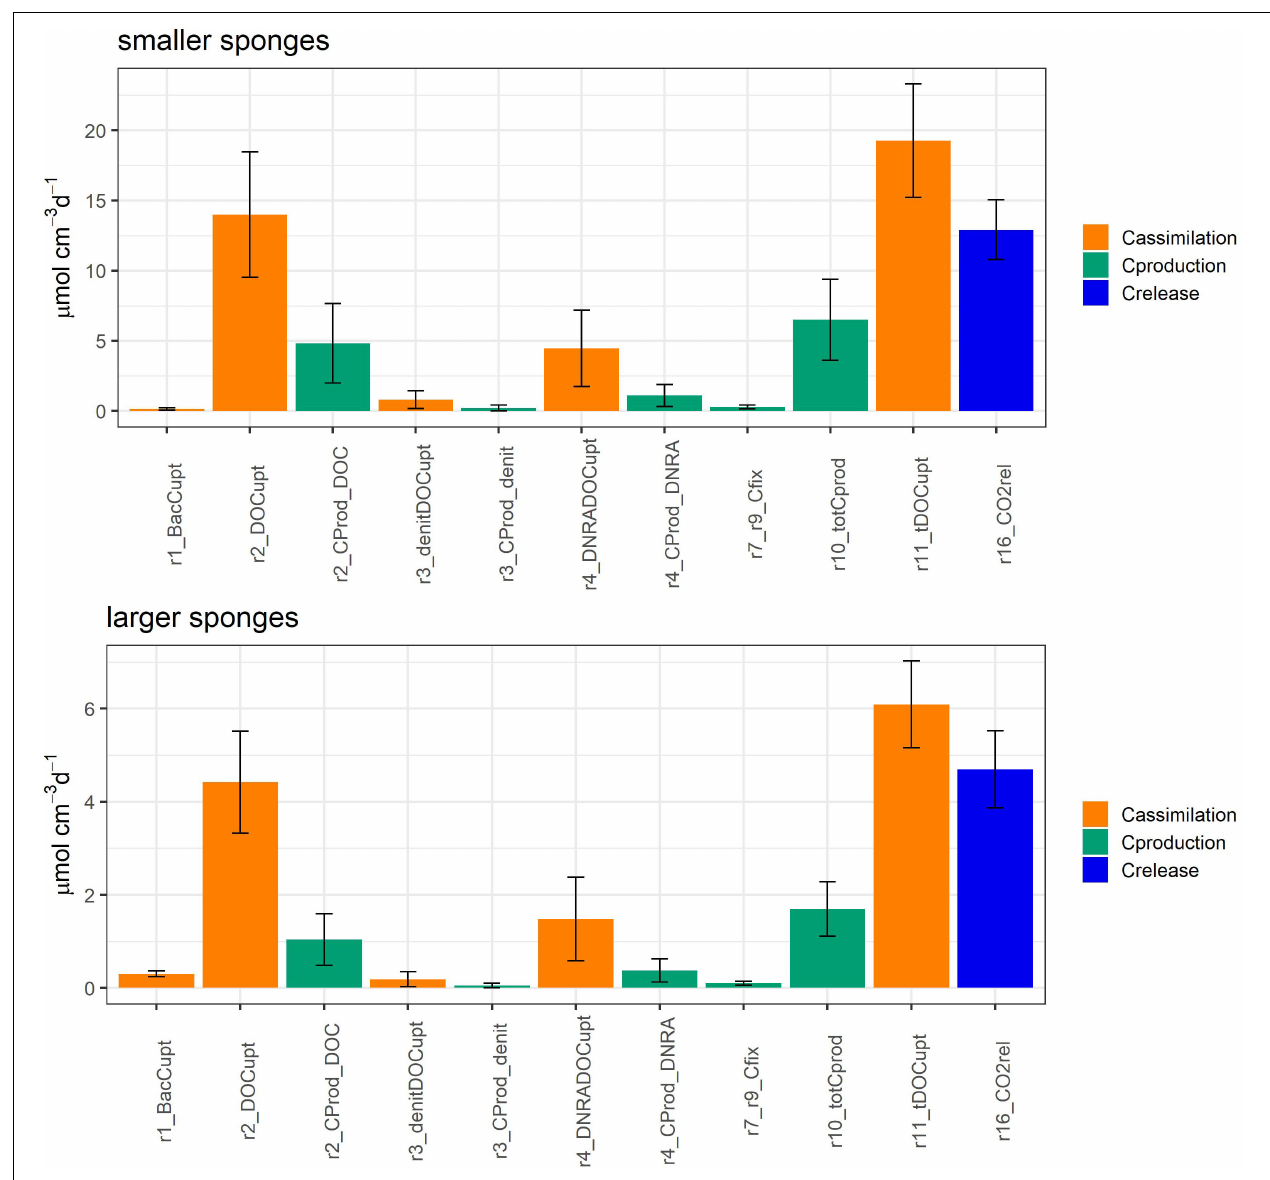
FIGURE 3 | Model-calculated average C fluxes ± SD ( µ mol C cm − 3 day − 1 ) in smaller Geodia barretti specimens (top) and larger G. barretti specimens (bottom). G. barretti assimilates bacteria (r1_BacCupt) and mainly dissolved organic carbon (r11_tDOCupt), which is used for aerobic respiration (r2_DOCupt), denitrification (r3_denitDOCupt), and DNRA (r4_DNRA_DOCupt). Production processes are shown in green, where r10_totCprod is the total C (biomass) production by the holobiont. r16_CO2rel (blue) is the net CO 2 release rate. The reaction numbers correspond to Figure 1 and Table 2